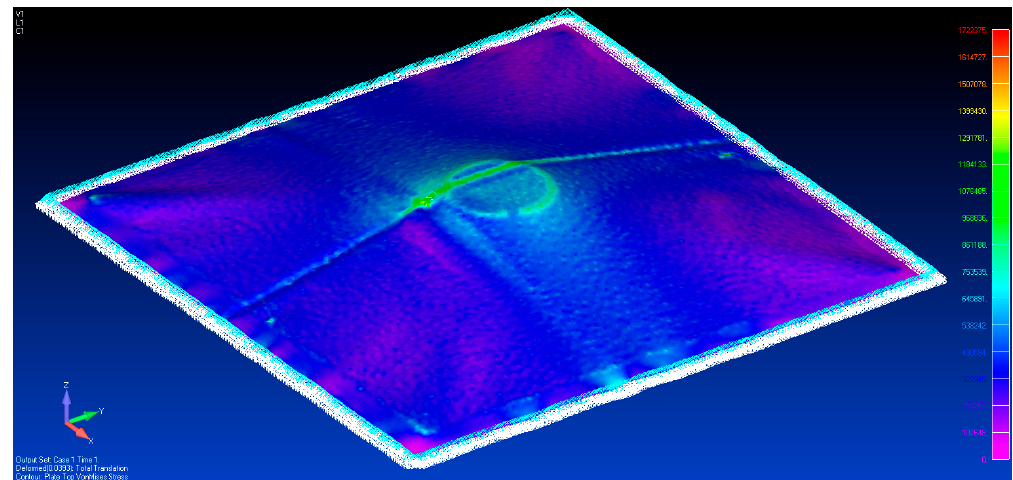
Figure 19. The von Mises stress distribution with two spacers placed beneath the membrane.